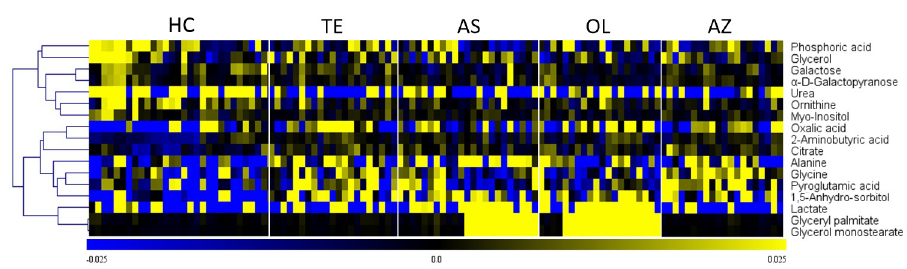
Fig 3. Heat map of the 17 biomarkers between TE, AS, OL, AZ and HC. The colors from blue to yellow indicate the relative contents of metabolites from low to high.